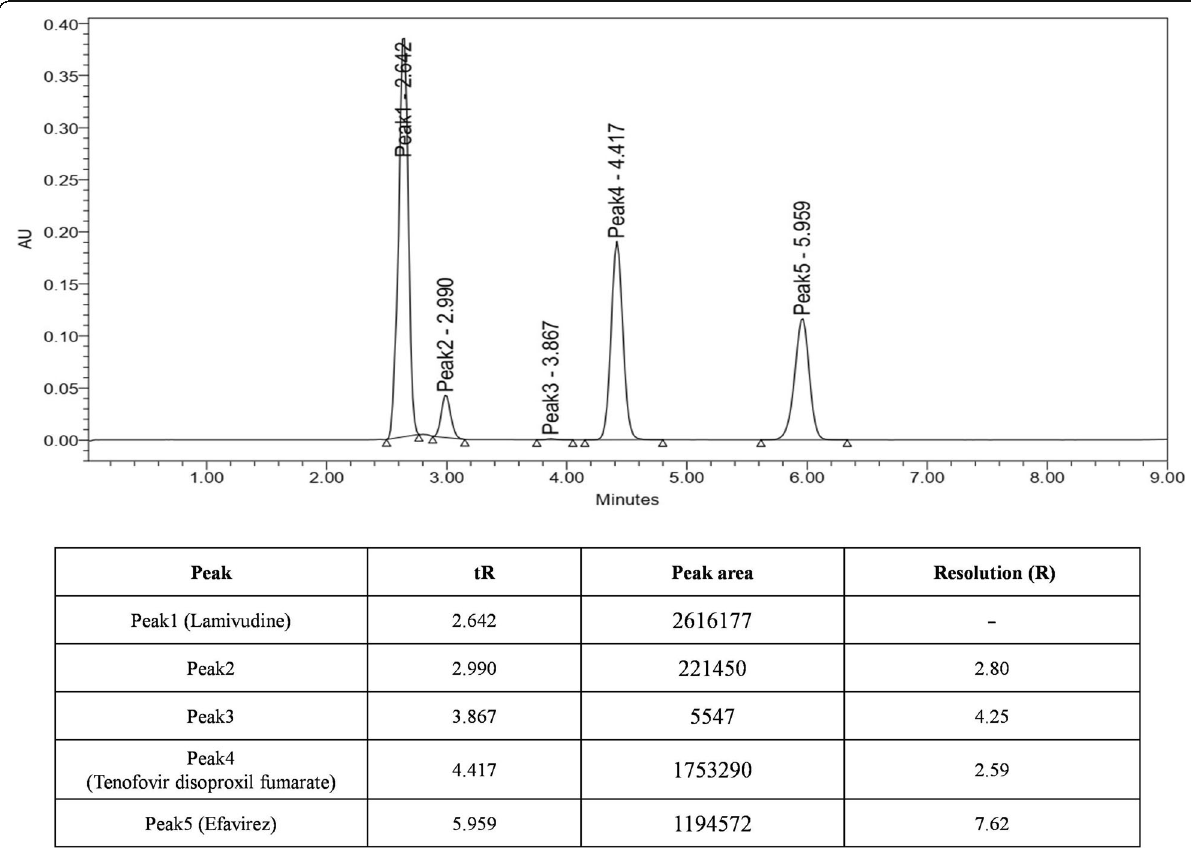
Fig. 6 Chromatogram of oxidative